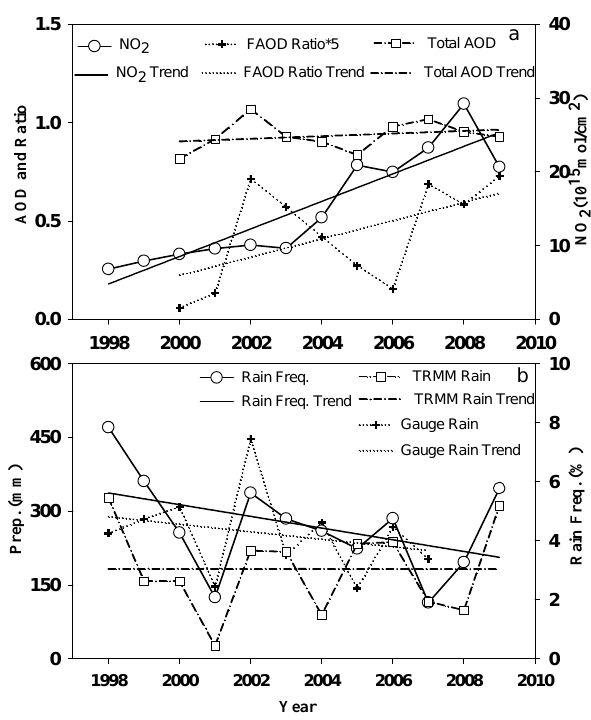
Fig. 2. (a) Time series of MODIS aerosol optical depth and satellite measured tropospheric NO 2 ; (b) Time series of TRMM PR rain fre- quency and rain amount, and surface rain gauge measured precipi- tation from 1998 to 2009 for the 1 ◦ × 1 ◦ grid centered at Shanghai